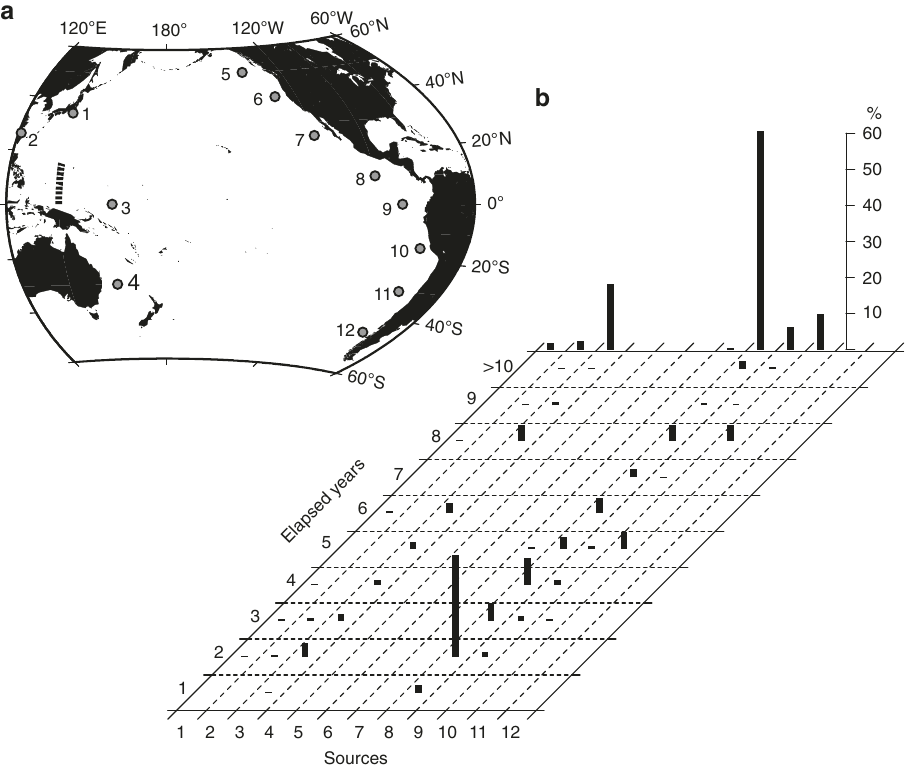
Fig. 7 Sources and elapsed years of modeled particles. Sources and years elapsed following the release of modeled particles found along 140°E from the Equator to 15°N (bold broken curve in a ) in February 2016 are shown in b . The model without the sink term was used to draw this fi gure. Source positions are shown in a . Bar heights represent percentages of the total particle number across the bold broken curve. Bars at the upper end represent cumulative percentages over all elapsed years at each Figs. 5, 6, 8, and 9 (mgm − 3 ). First, the size distribution ( υ ) of the microplastics collected in the fi eld survey across the entire meridional transect was approximated to: υ δ ð Þ ¼ βδ e (cid:3) αδ ; ð 4 Þ where δ denotes the size of the microplastics, and α and β were calculated as 0.83 mm − 1 and 3.8× 10 − 2 pieces mm − 2 , respectively, in a least square sense (Supplementary Fig. 7; correlation coef fi cient of 0.89, signi fi cant at the 99% con- fi dence level following a t test). Note that α represents the reciprocal of the mode size (1.2mm). We assumed that an approximation in the form of Eq. (4) was ubiquitously available for the size distribution of microplastics collected using neuston nets, and that the mode size (hence, α ) was invariant, irrespective of the different situations suggested by previous studies 1,7,9 . Integrating Eq. (4) over the